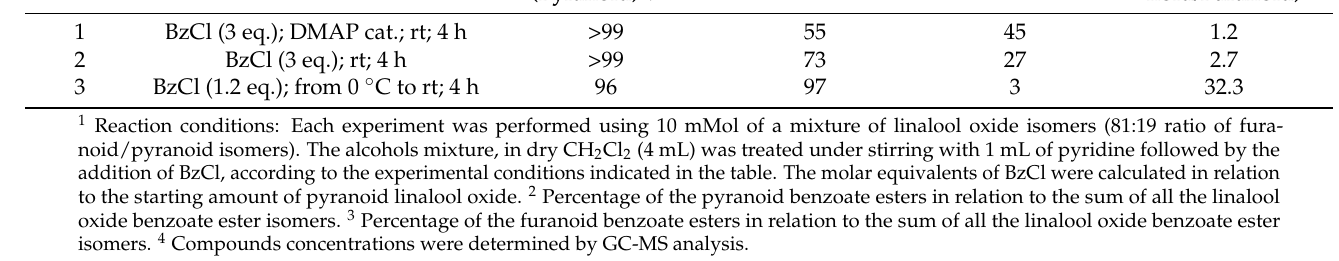
Entry Experimental Conditions 1